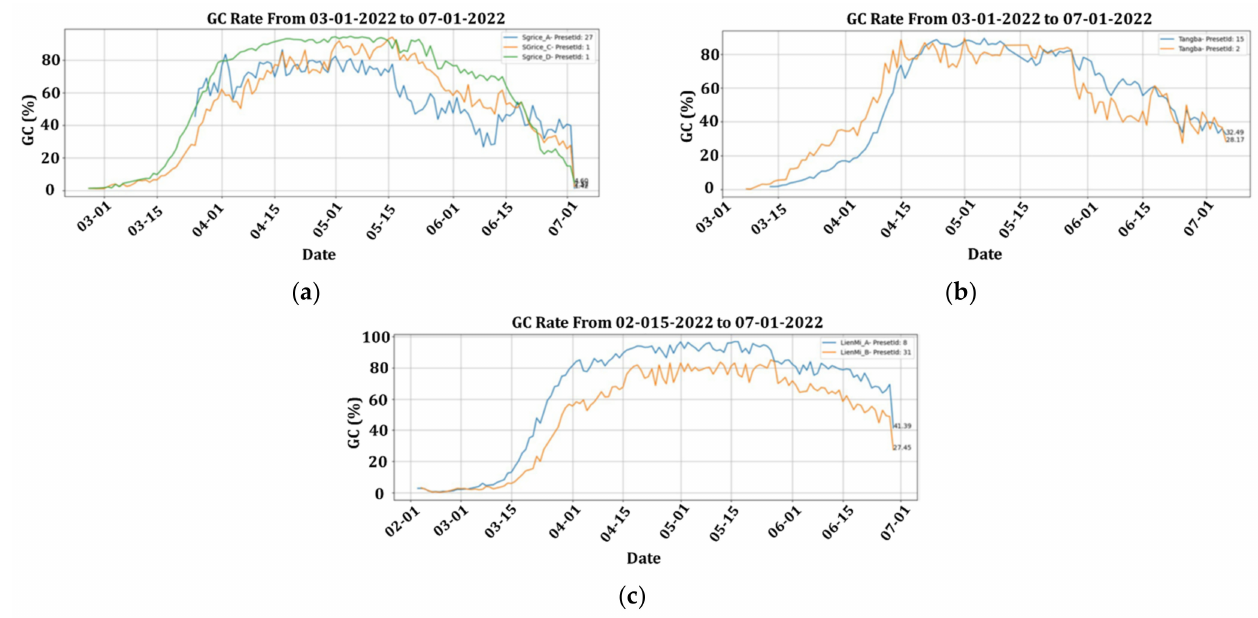
Figure 15. GC Rate for the Three Experimental Fields. ( a ) GC in Field 1 having sgrice Rice. ( b ) GC in Field 2 having Tangba Rice. ( c ) GC in Field 2 having Tangba